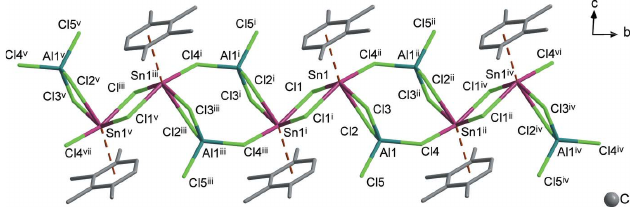
Figure 2 Coordination polymeric chain in the crystal of 1 [view direction [100];